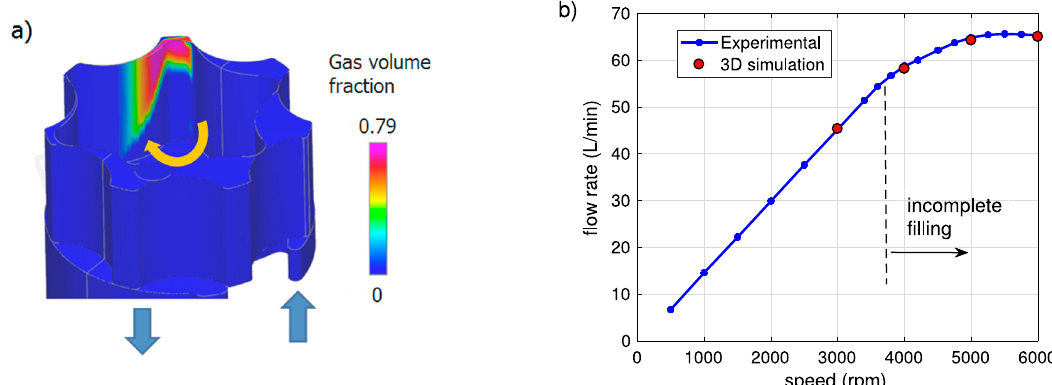
Figure 21. ( a ) Gas fraction of a gerotor pump simulated with PumpLinx; ( b ) example of steady-state characteristic flow-speed at constant pressure and temperature.